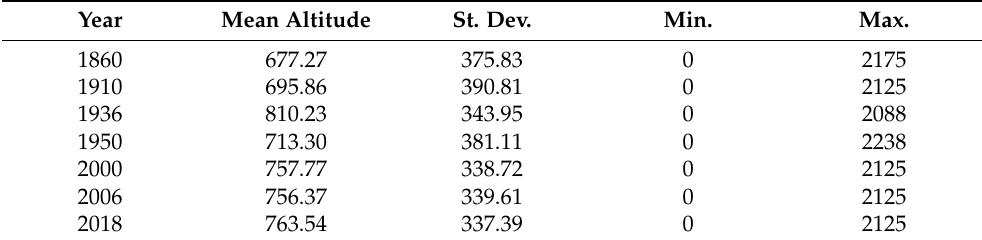
Table 5. Descriptive statistics related to altitude (meters a.s.l.) for each year of analysis.